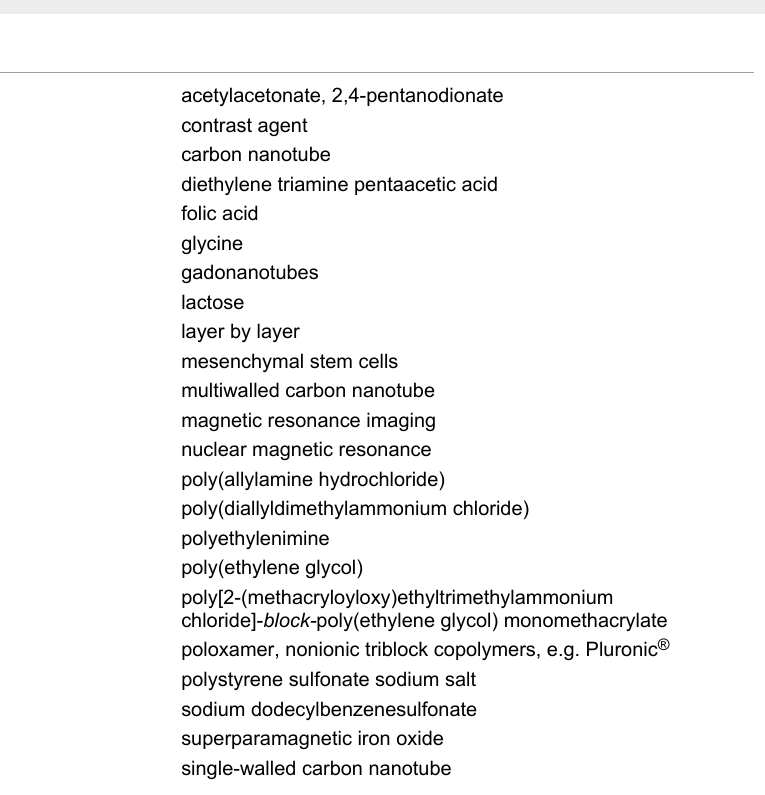
Table 4: List of abbreviations.